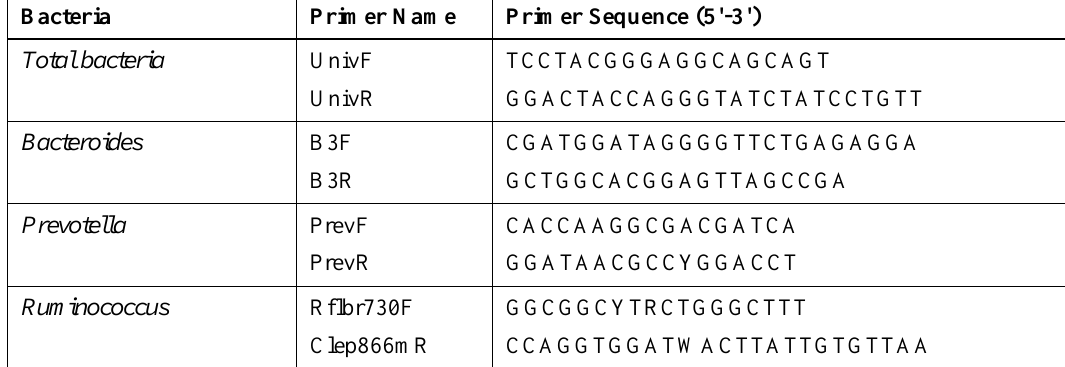
Table 1. Primer sequences and different bacteria types.